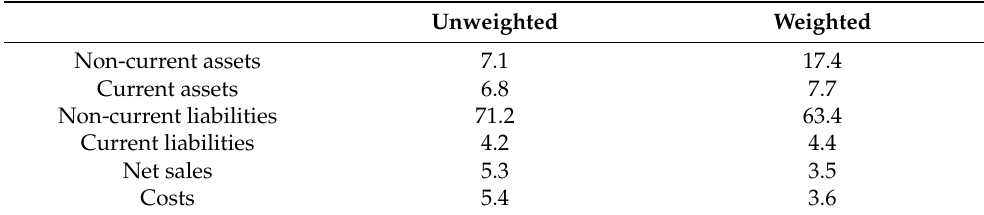
Table 2. Contributions of the parts to total CLR total variance (%) labelled according to the accounting figure in the numerator. Unweighted and weighted.